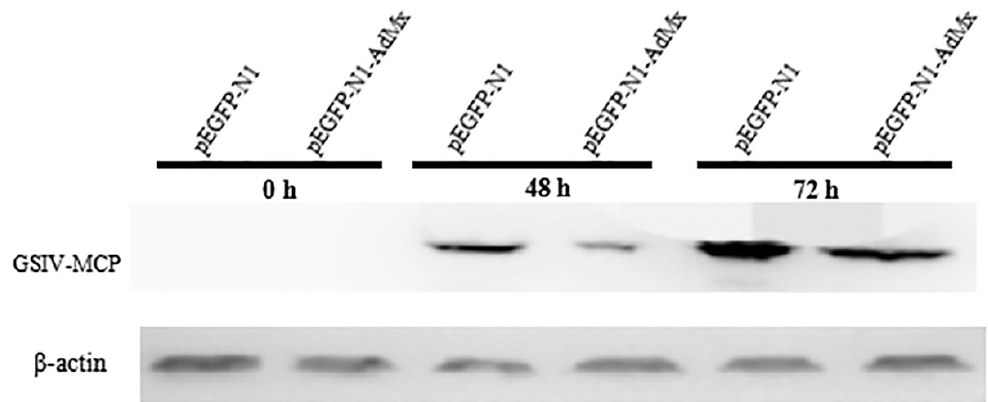
Figure 9. Western blot analysis of MCP protein expression. Western blot was performed on equal amounts of protein harvested from pEGFP-N1 transfected GSM cells and pEGFP-N1-AdMx transfected GSM cells at 0 h, 48 h and 72 h post GSIV infection using anti-MCP monoclonal antibody. β -actin was used as a loading control.